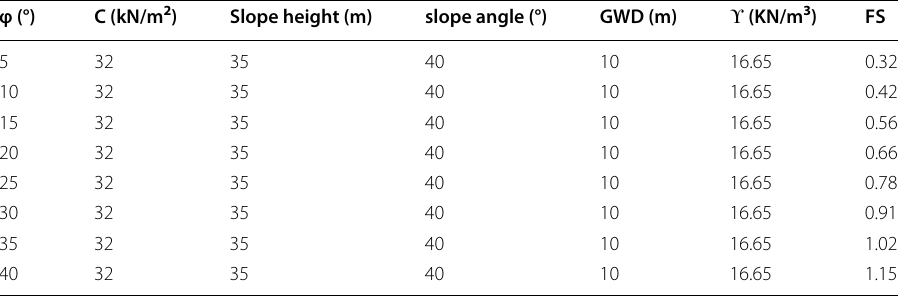
Table 13 Implication of internal friction angle on a slope factor of